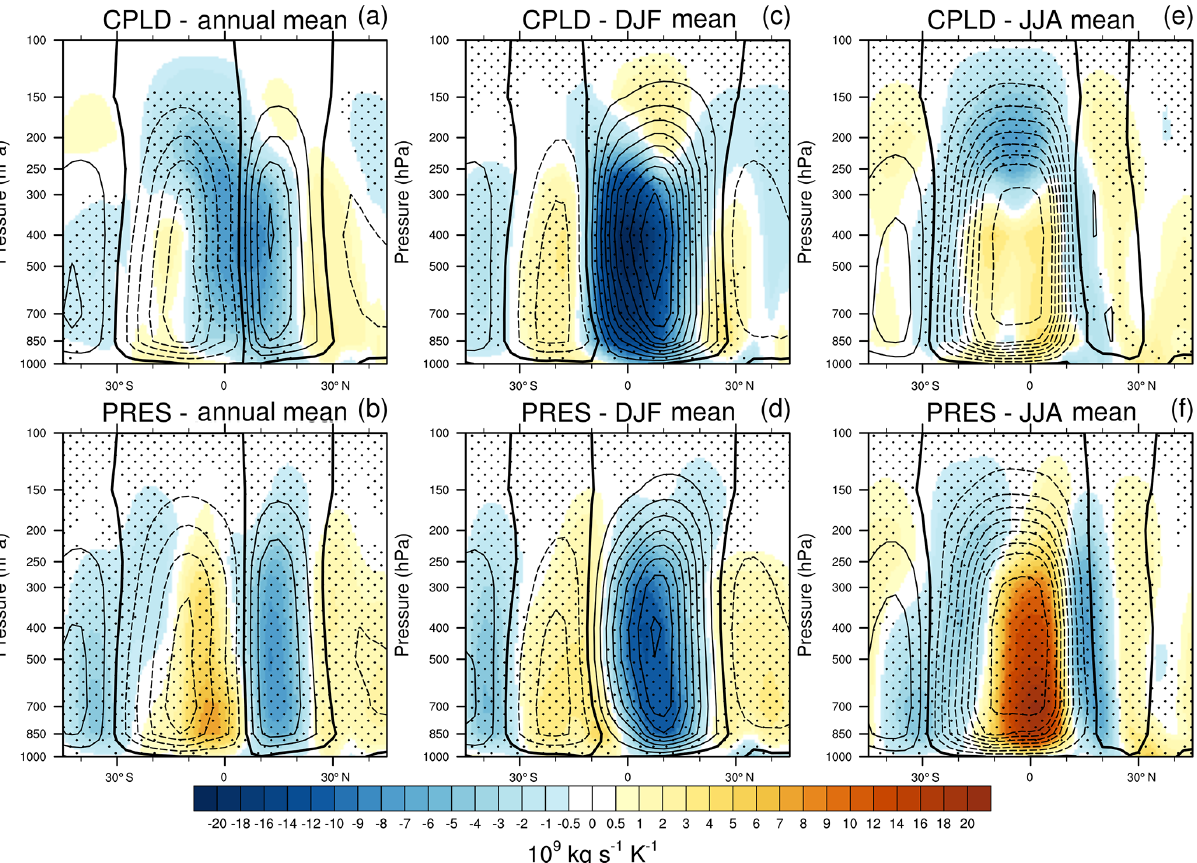
Figure 5. CPLD (a, c, e) and PRES (b, d, f) meridional mass stream function response (shading) and preindustrial control climatology (contours, interval 2 × 10 10 kgs − 1 , with dashed lines as negative and the zero line thickened): (a, b) annual mean, (c, d) DJF mean, (e, f) JJA mean. Stippling as in Fig.